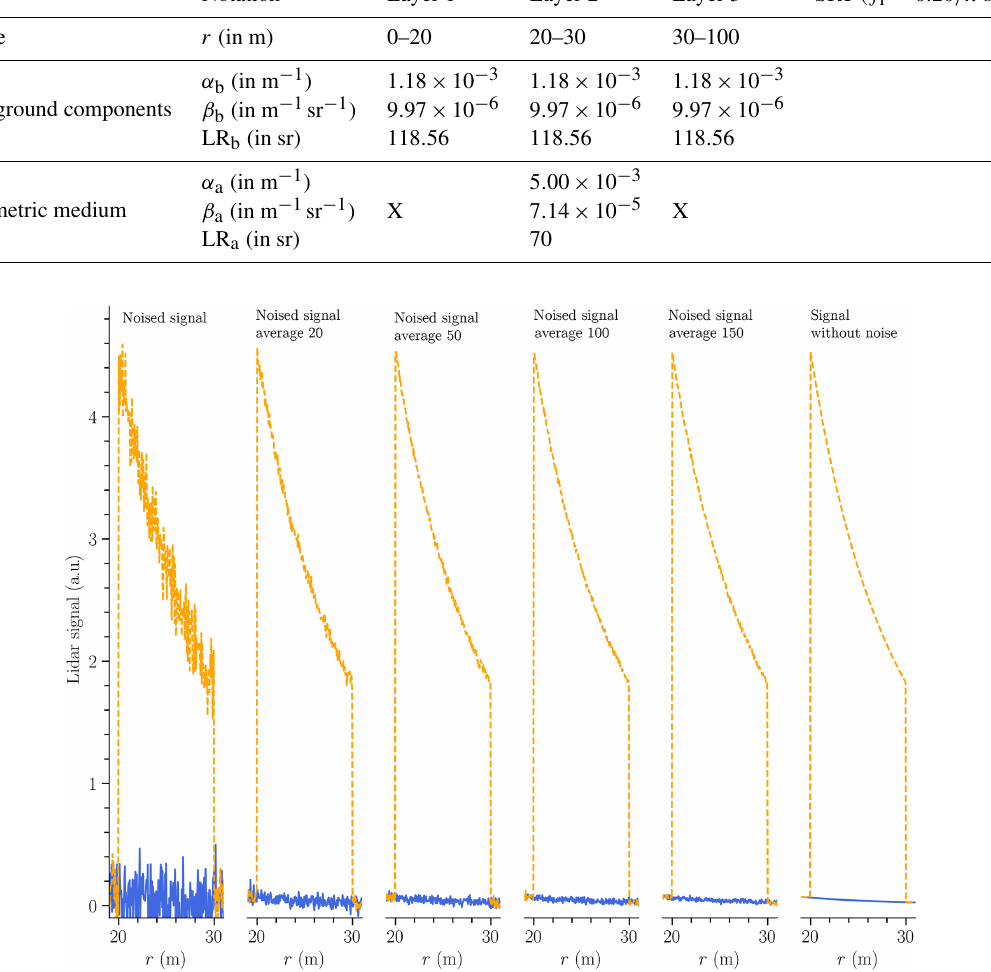
Figure 4. Lidar datasets used in the inversion method. In blue (orange), the lidar signal in the absence (presence) of the volumetric media under